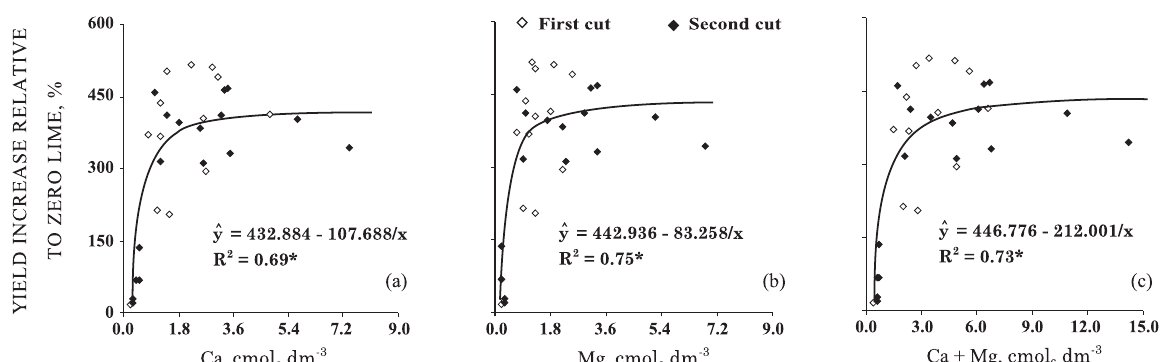
Figure 2. Yield increase relative to zero lime : Alfalfa yield (%) of control (zero lime) influenced by concentrations of exchangeable Ca (a), Mg (b), and Ca+Mg (c) in an